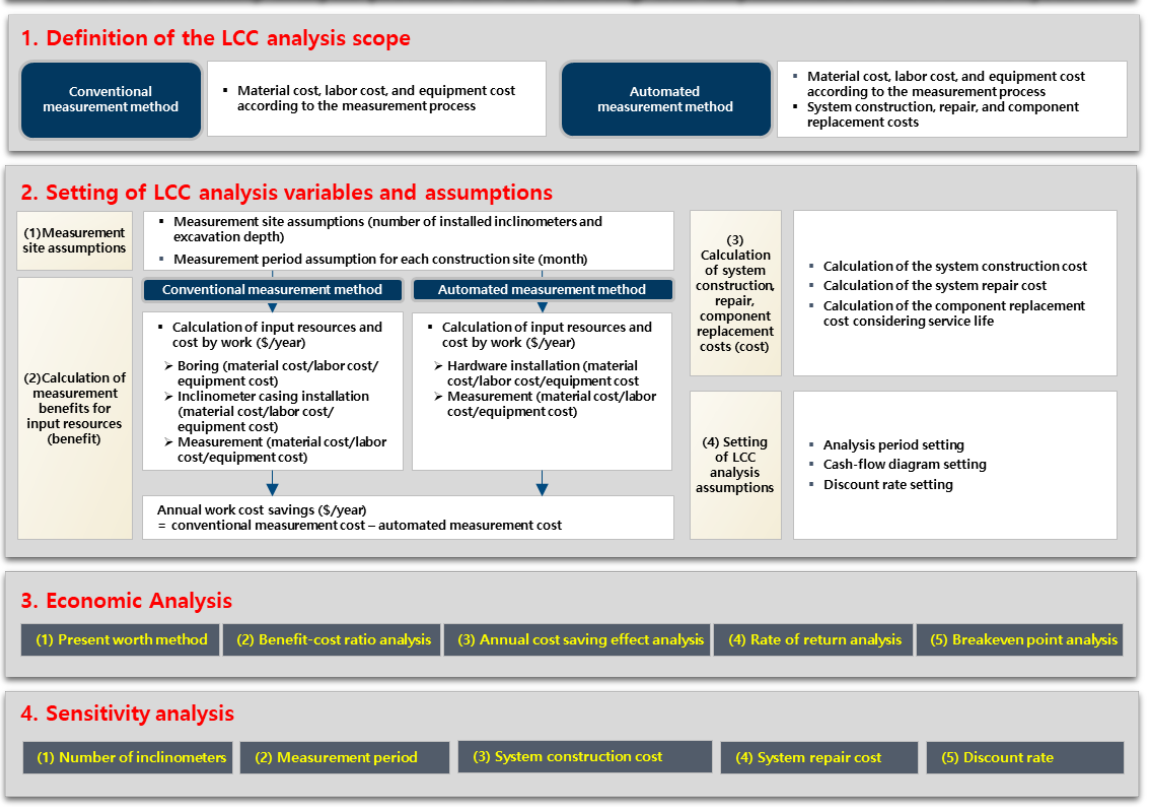
Figure 12. Economic feasibility analysis process.